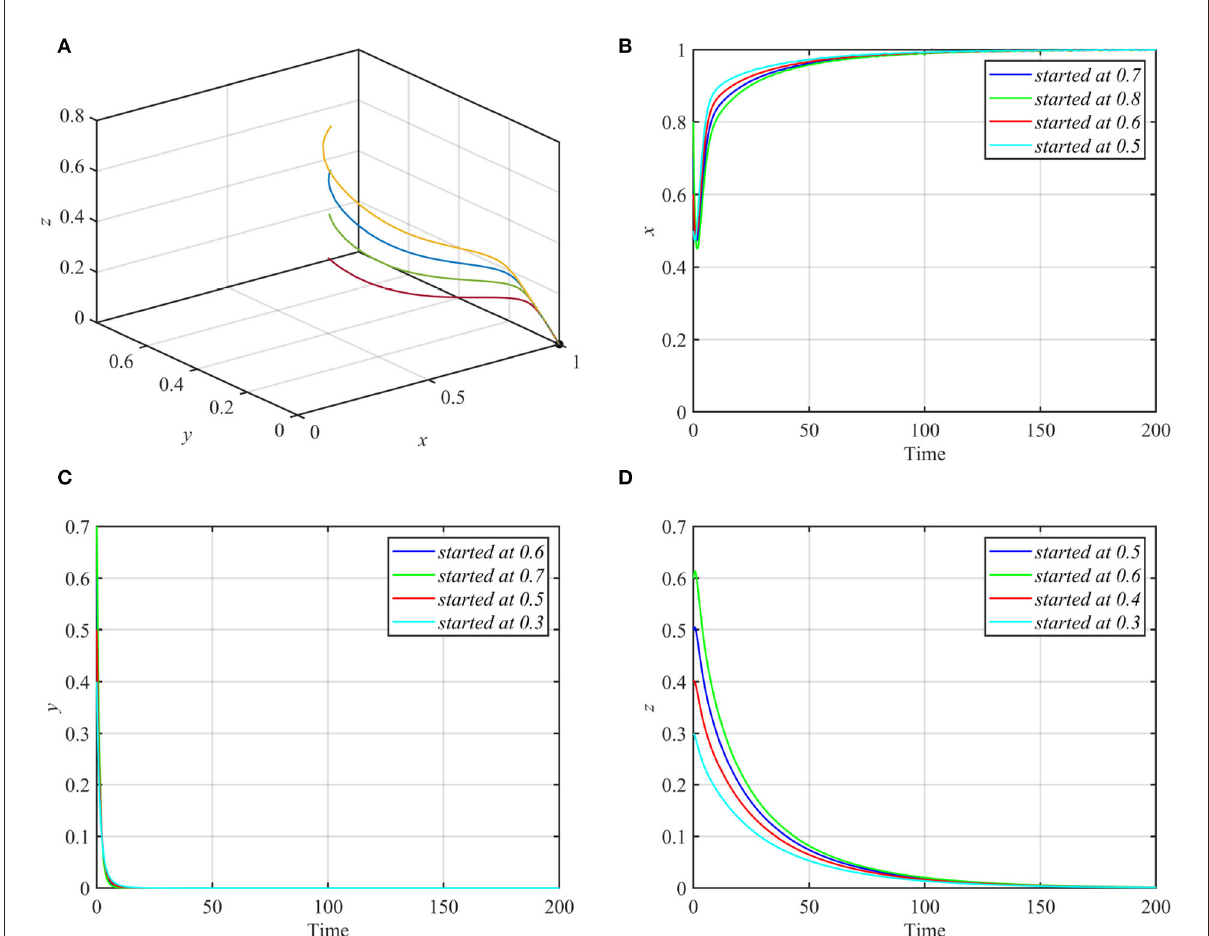
FIGURE7 Globally asymptotically stable axial equilibrium point for d 1 Time series for trajectories of x . (C) Time series for trajectories of y . (D) Time series for trajectories of z